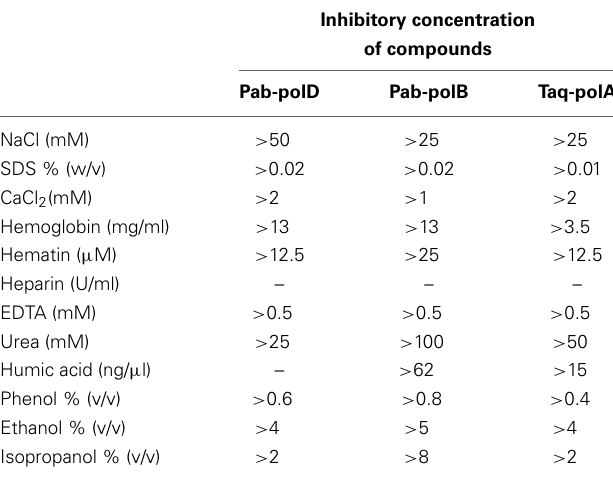
Table 3 | Potential inhibitory effects of organic and inorganic substances on